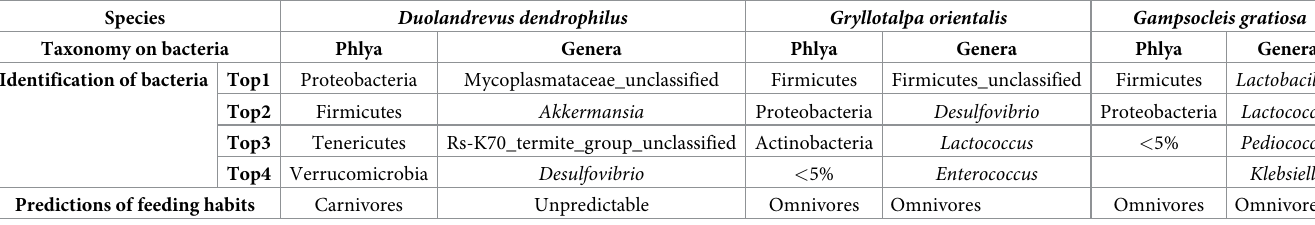
Table 4. Assess dietary pattern using dominant bacterial community composition.